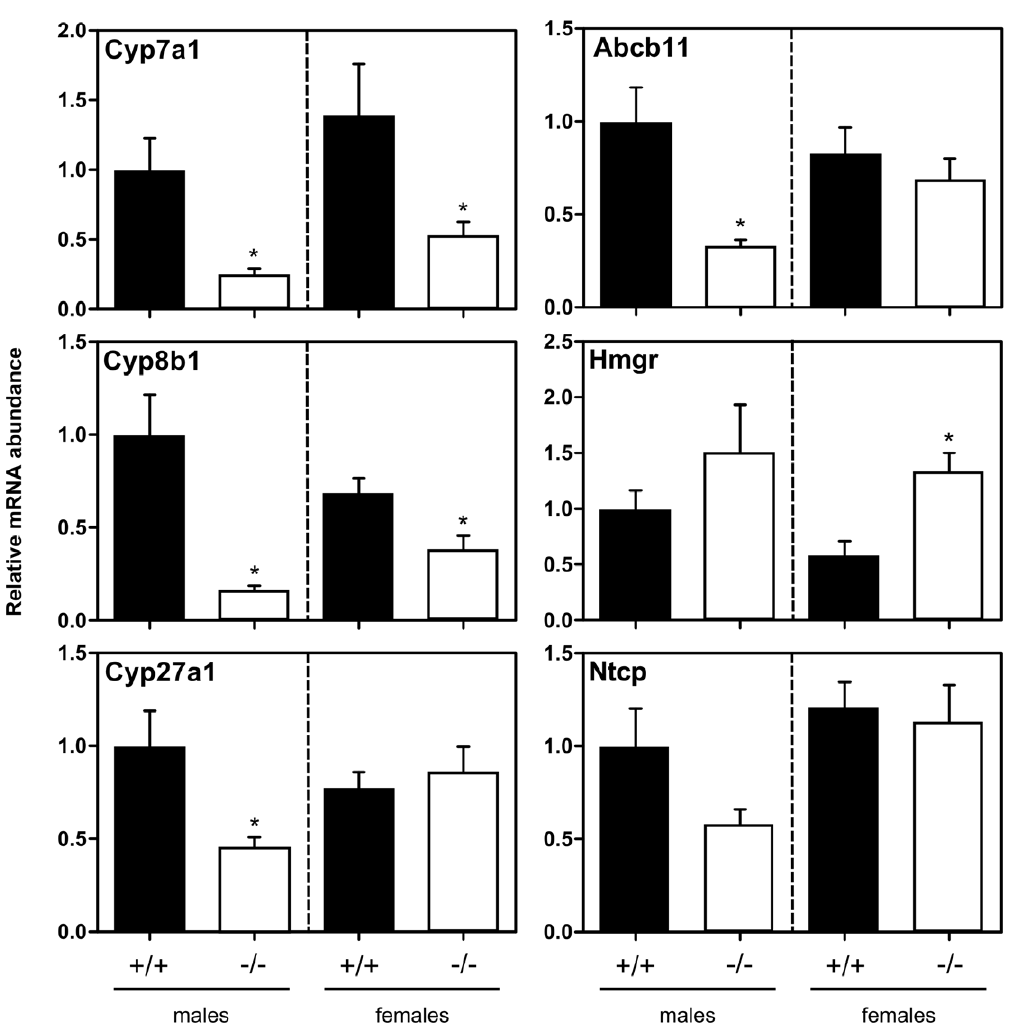
Figure 5. Survey of gene expression in the liver. qPCR analysis of liver RNA from Fabp6 + / + (black bars) and Fabp6 2 / 2 (white bars) mice were done in duplicates. The abundance (mean 6 SEM) of target mRNAs was normalized to internal standards and expressed relative male wild-type mice. * P , 0.05, vs. wild-type.